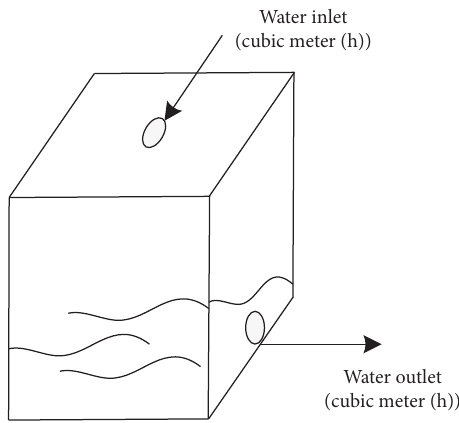
Figure 6: Water tank similar to the dispatching